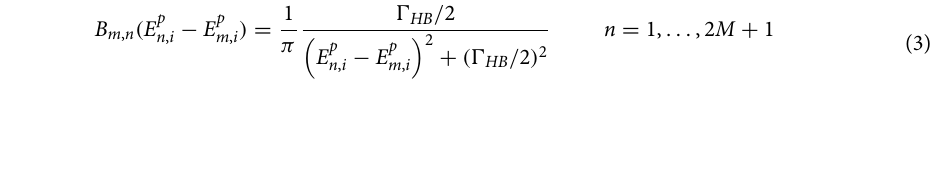
Figure 2. The modal analysis of two-channel AOM. ( A ) Band structure of the CdSe/ZnS core/shell two- channel AOM which indicates that the difference between the ground states of the valence and conductive bands in defined QDs is about 2.2 eV for channel 1 and 2 eV for channel 2. Also, the difference between the ground state and excited state of the conductive bands is 0.4 eV for channel 1 and 0.25 eV for channel 2. ( B ) Wave functions of CdSe QDs simulated by solving 3D Schrodinger equation in FEM software. A cross section of 3D core/shell structure in x–y plane is specified and the wave function of GS c s (left) and ES c s (right) of main mode is illustrated for channel-1 and ( C ) for interaction leads to a temperature-dependent linewidth. The HB is modeled by a Lorentzian function with Ŵ HB as its FWHM which is considered as 20 meV at room temperature 38,42 .